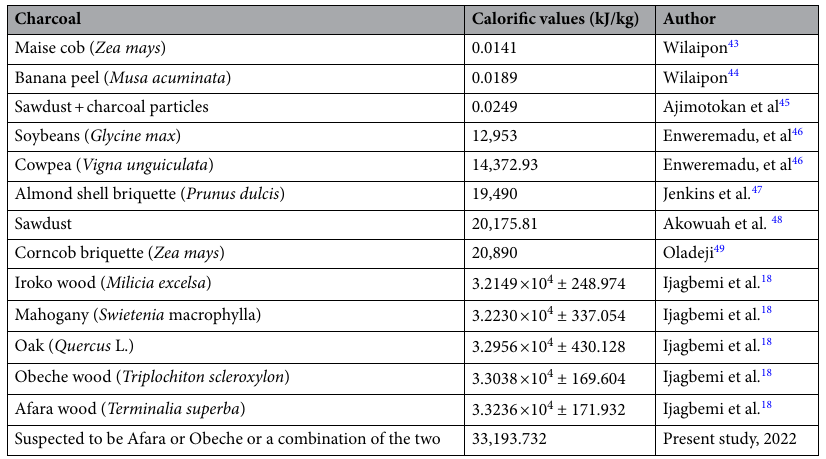
Table 6. Charcoals sourced from different biomass. Bracketed words are the scientific names of the